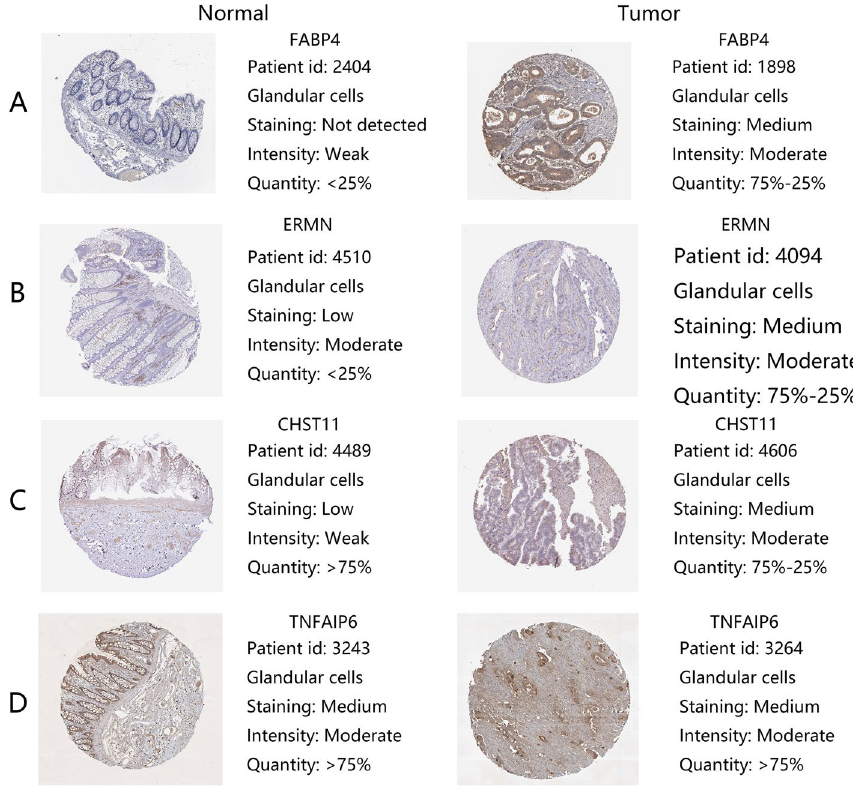
Figure 8. Immunohistochemistry analysis for FABP4 ( A ), ERMN ( B ), CHST11 ( C ), and TNFAIP6 ( D ) in colorectal cancer (HPA database, http:// www. prote inatl as.